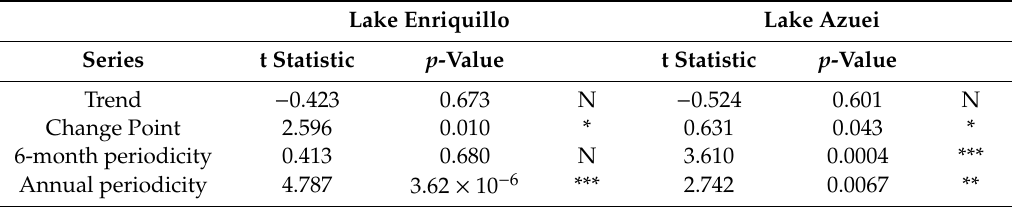
Table 4. Result of linear regression analysis for trend, change point and seasonality